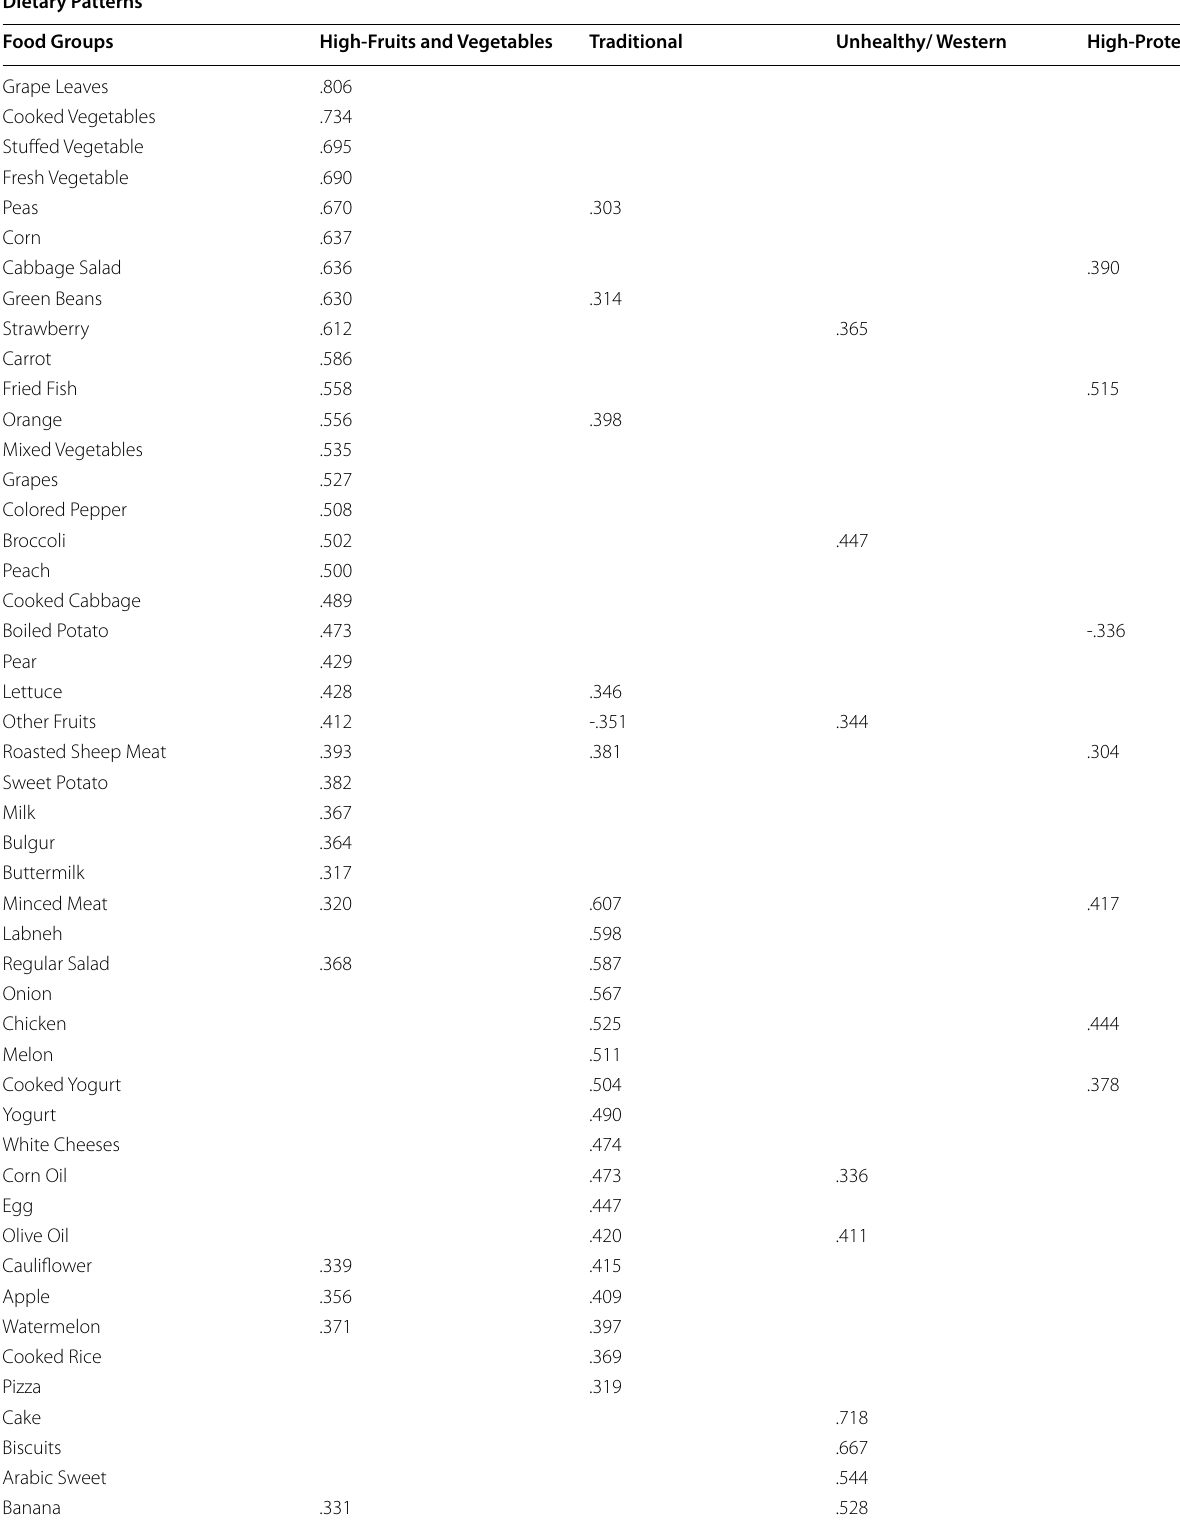
Table 1 Factor loading matrix for the two major dietary patterns identified in the study sample Dietary